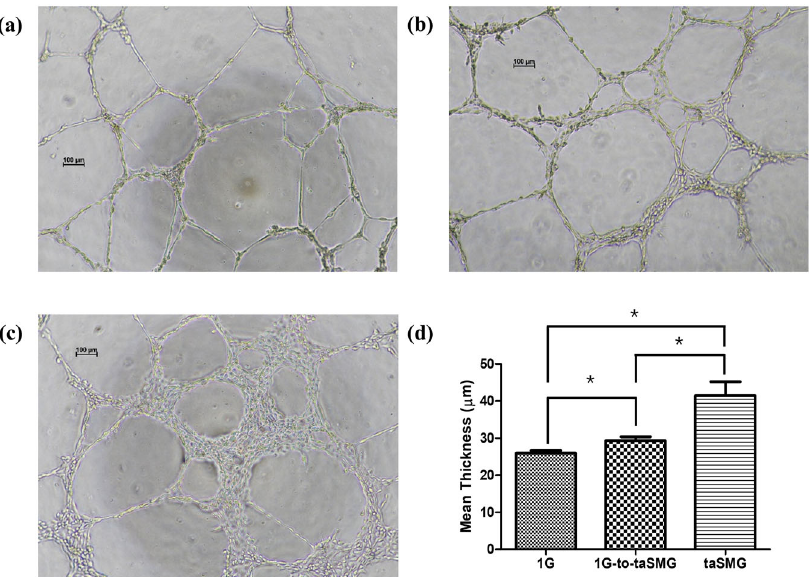
Fig. 1 Arrangement of HUVECs under various gravity environments using Matrigel. After 18 h of incubation under a 1 G, b 1G-to-taSMG, and c taSMG. Scale bars: 100 μ m. d Quantitative comparison of thickness between groups. Data represent the mean ± SEM ( n = 8 – 9, * p < 0.05).